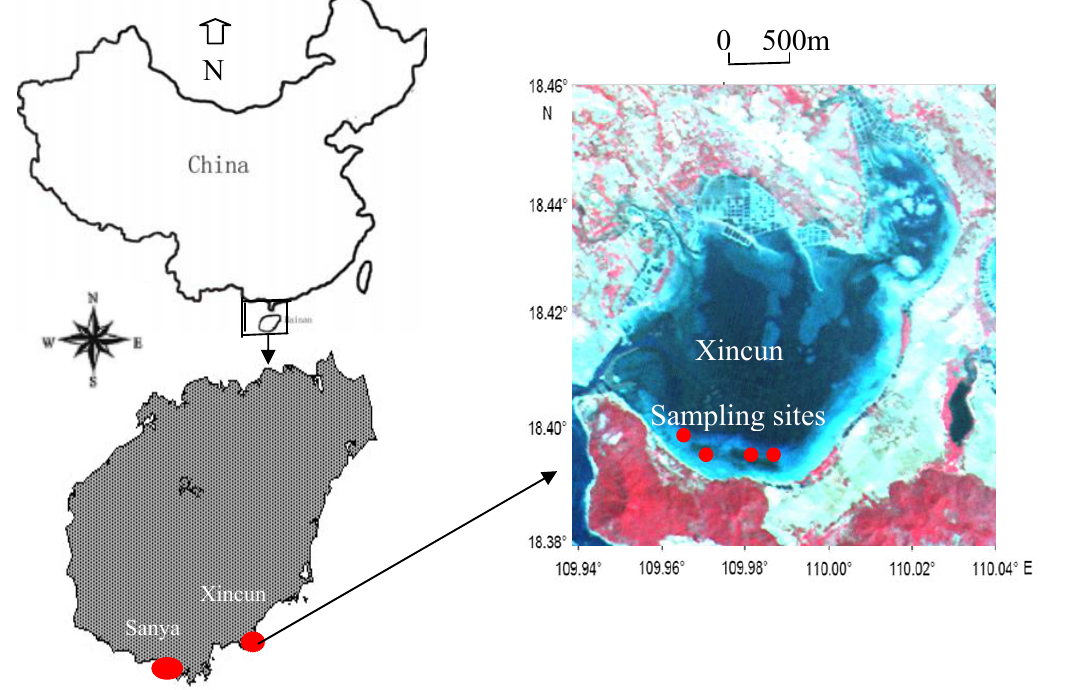
Figure 1. Study area in Xincun Bay, Hainan Province,